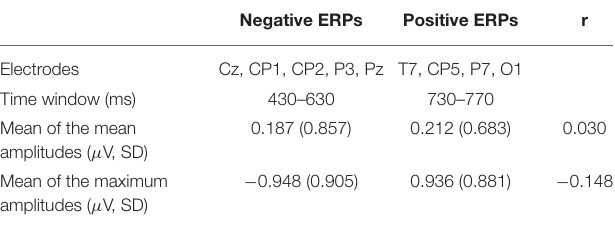
TABLE 6 | Means of the mean amplitudes and the maximum amplitudes for ERPs at subordinate verbs in In Syntactic Island for Head-noun First.